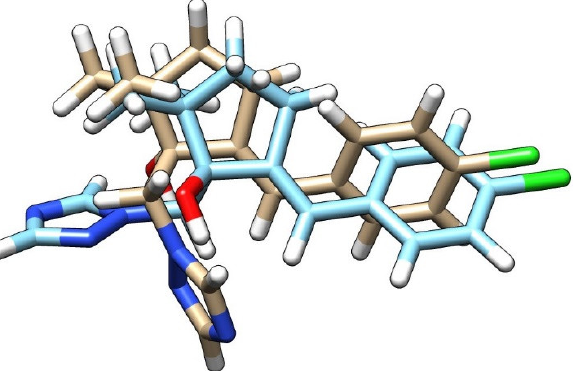
Figure 1. Chemical structures of the stereoisomers of triticonazole: (R)-triticonazole (carbon—brown), (S)-triticonazole (carbon—light blue), nitrogen—blue, oxygen—red, chloride—green, hydrogen—white.